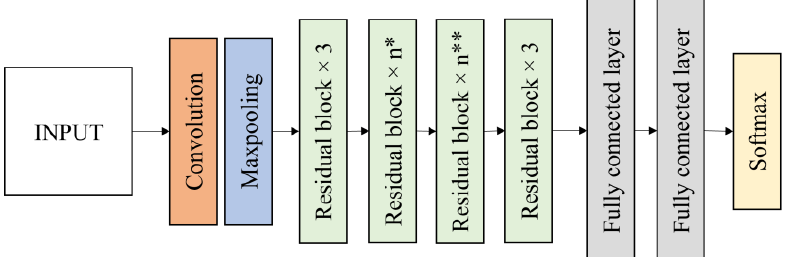
Figure 7. Fine-tuned ResNet50 and ResNet152 architecture (n* = 4 for ResNet50, 8 for ResNet152; n** = 6 for ResNet50, 36 for ResNet152).